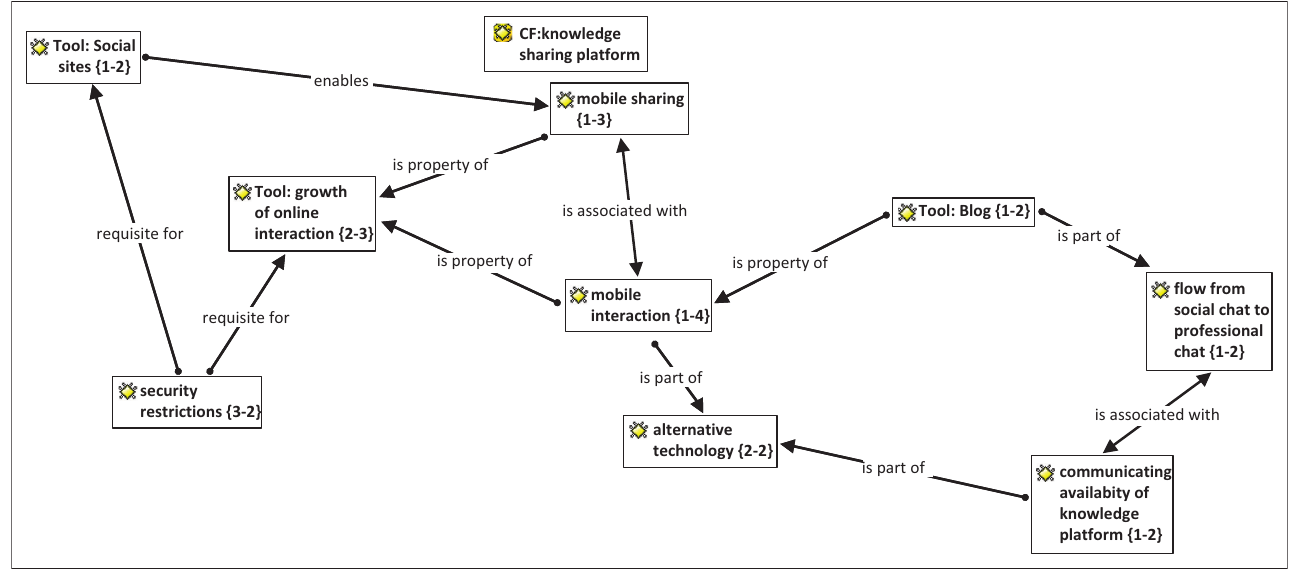
FIGURE 1: Knowledge sharing